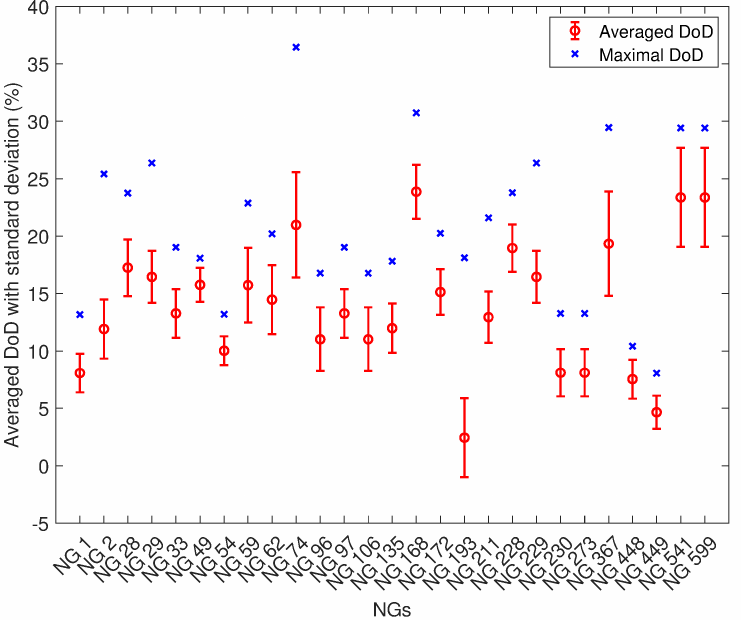
Figure 4. Averaged and maximal depth of discharge of the nanogrids in Ambohimena over 3 months.